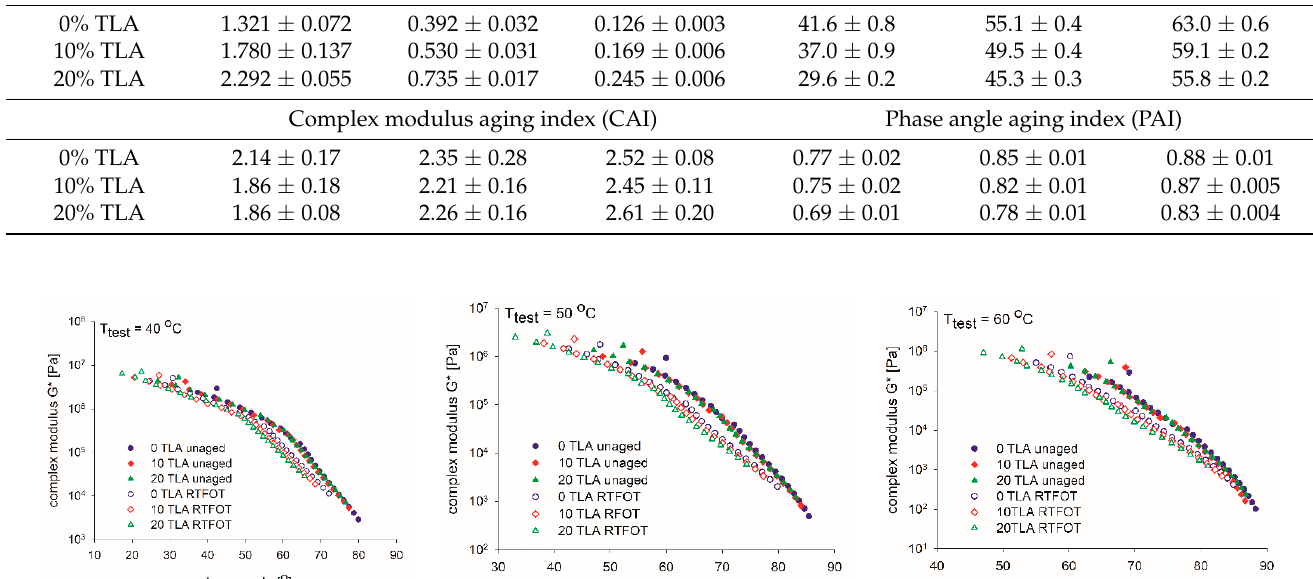
Figure 5. Black curves of the TLA-modified binders before and after the RTFOT aging at the specified test temperature.